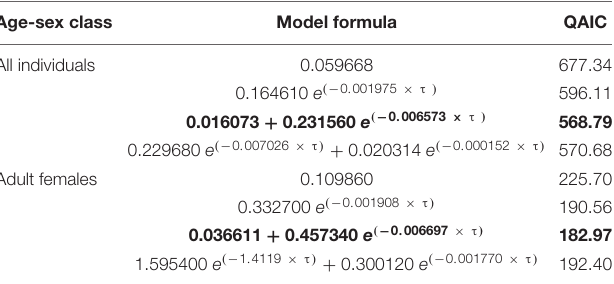
TABLE 5 | Models fitted to the standardised lagged association rate (SLAR) for all individuals and for adult